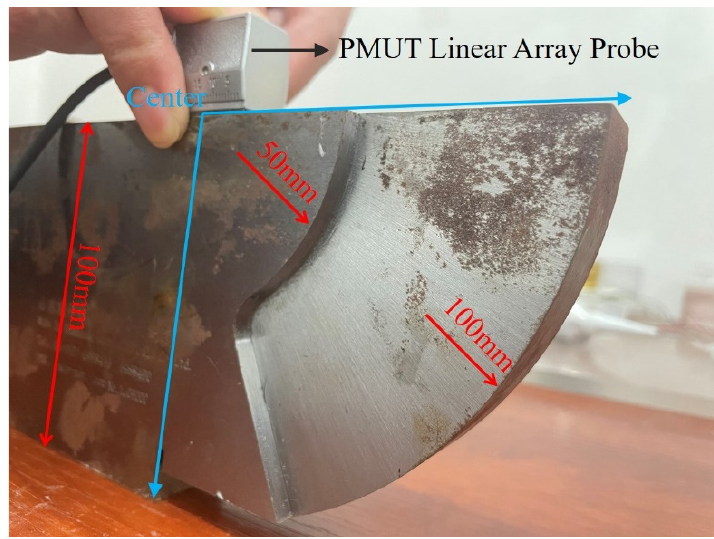
Figure 9. Illustration of calibration with the ultrasonic calibration test